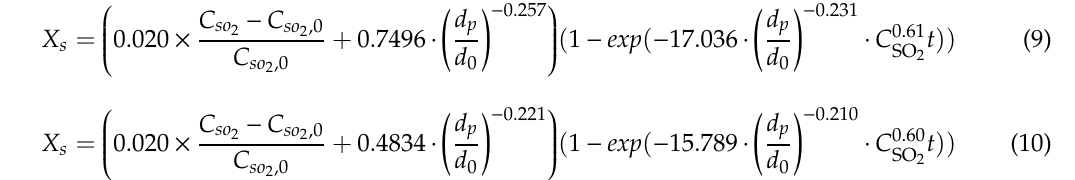
Figure 14. The relationship between X s,max and d p of Shengzhou limestone (500 ppm SO 2 ).